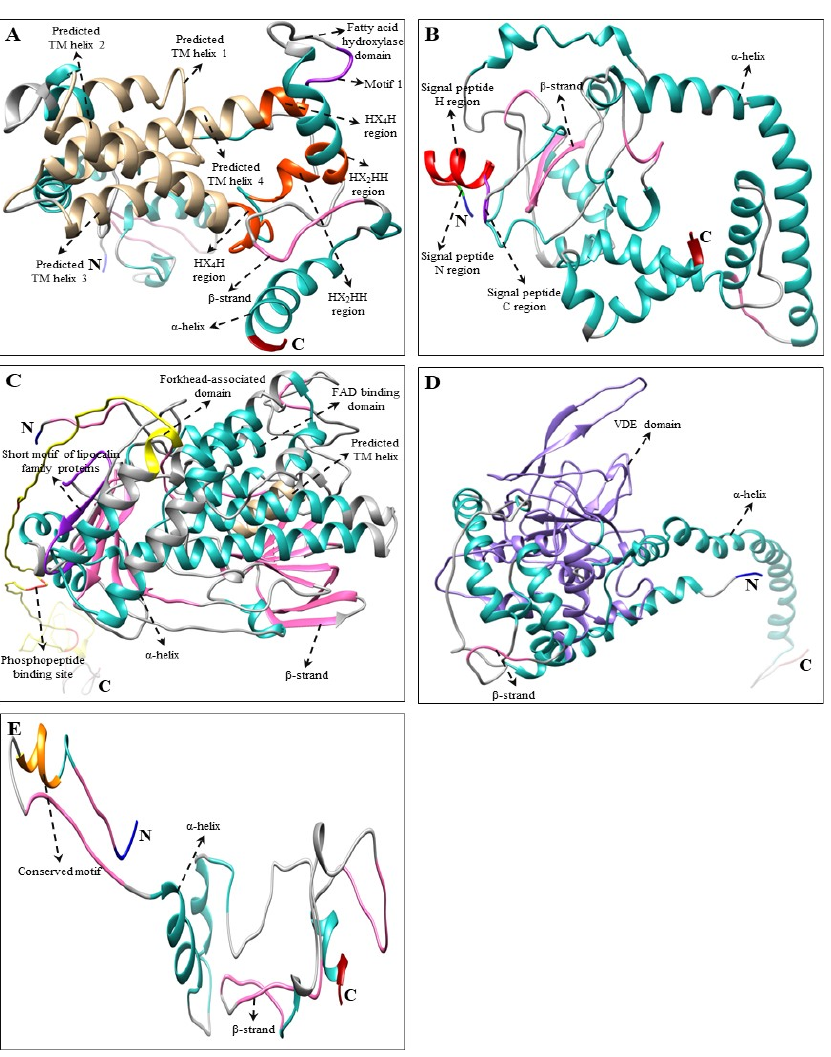
Figure 3. Three-dimensional structure of XBP genes of C. majus . ( A ) CmCHXB , ( B ) CmCHXE (partial ORF), ( C ) CmZEP , ( D ) CmVDE , and ( E ) CmCCS (partial ORF) structures were produced by using Chimera 1.14 software [76]. The amino (NH 2 ) and carboxyl (COOH) termini are shown in blue and dark red, respectively. In these 3D structures, α -helices are shown in light sea green whereas β -strands are sown in hot pink. Multiple alignments of each gene are shown in Figure S3. The common genes responsible for both CBP and XBP are CmCHXB and CmCHXE